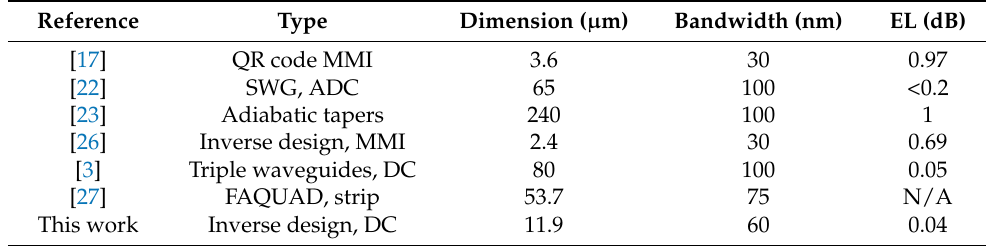
Table 4. Simulation results comparison of the reported power splitter and this Work.